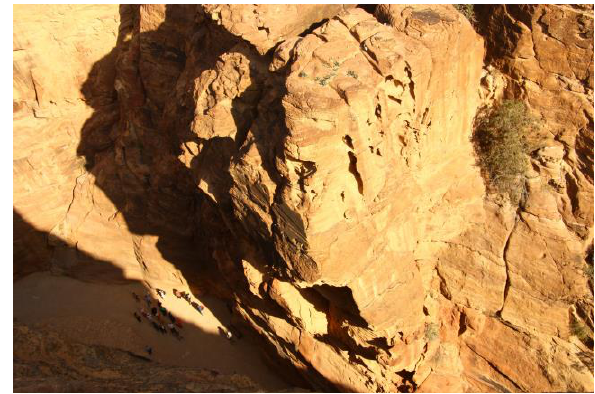
Figure 4. Large unstable block located in sector 5 equipped with wire deformometer, tilt meter and air and humidity